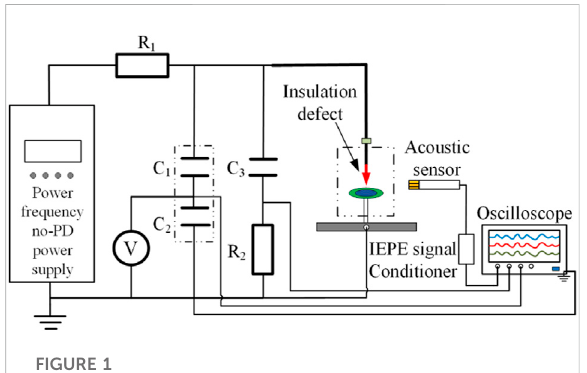
FIGURE 1 Audible acoustic test circuit of epoxy resins with PD defects.